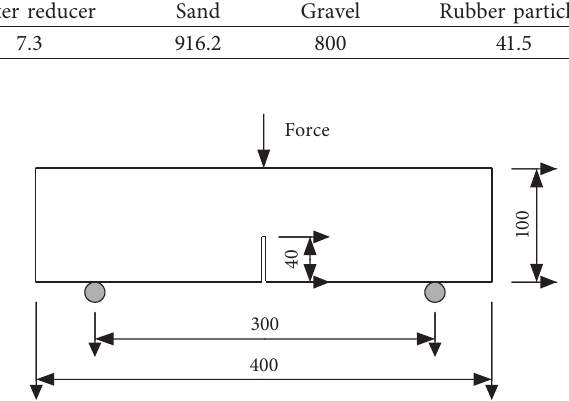
Figure 2: Loading schematic diagram (unit: